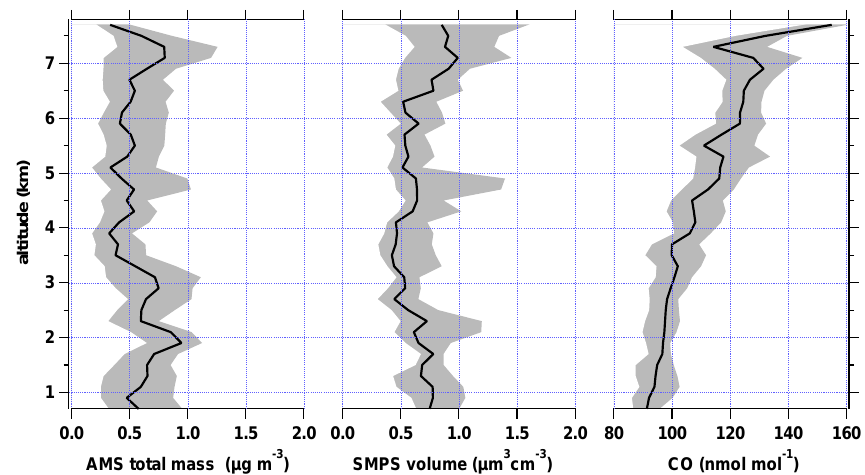
Fig. 10. Vertical profile of total AMS aerosol mass, SMPS aerosol volume, and CO mixing ratio for all 8 POLARCAT flights. The black lines show the median concentration for 200m altitude bins while the grey shaded areas comprise the inter-quartile concentrations. The data has been smoothed by a sliding average comprising 5 altitude bins. Aerosol mass and volume are given in